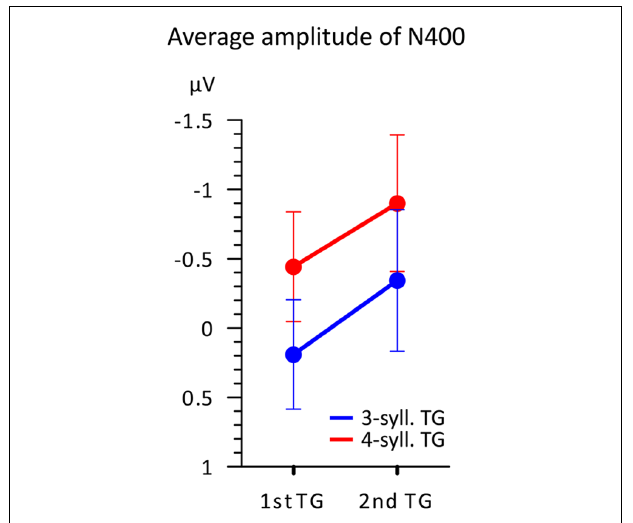
FIGURE 6 |Average amplitude ( n = 16) in the 350–450 ms time-window according to bothTG position (first vs. second) andTG length (blue = 3-syll. vs. red = 4-syll.). Vertical bars represent standard